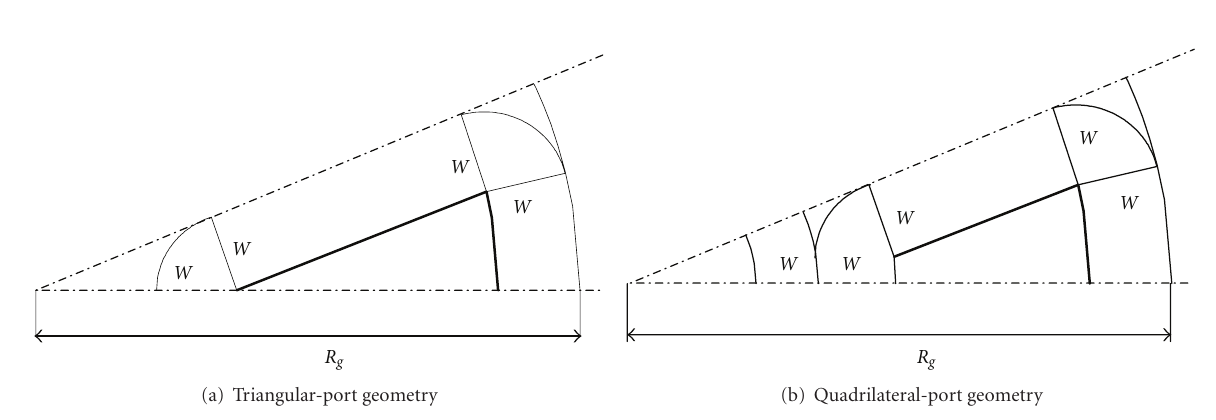
Figure 5: Multiport